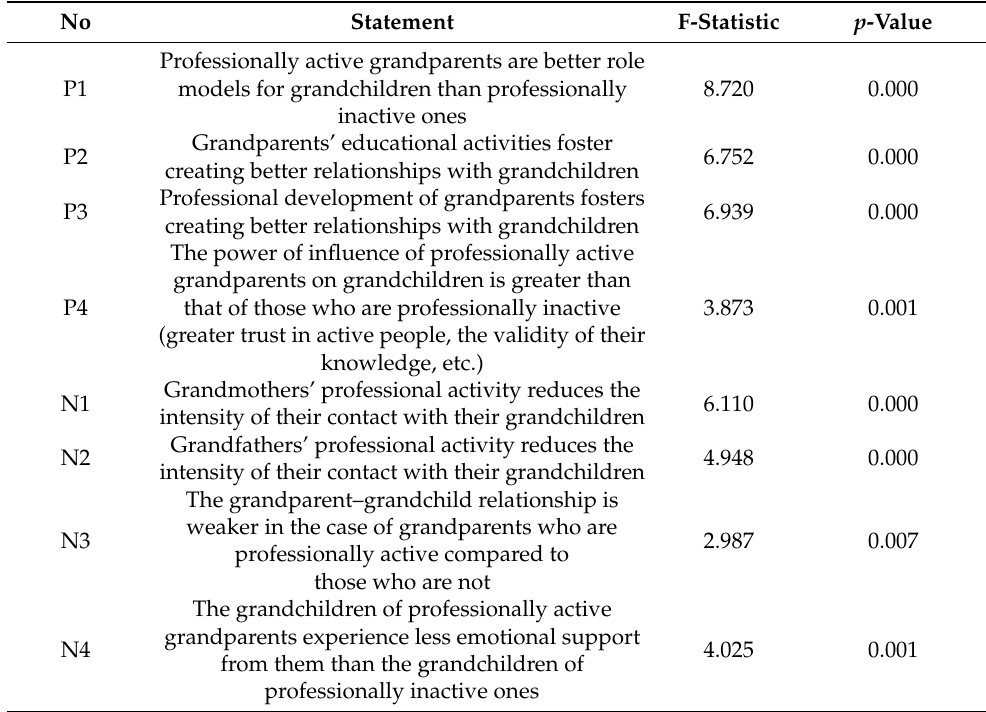
Table 4. Results of ANOVA for the grouping variable